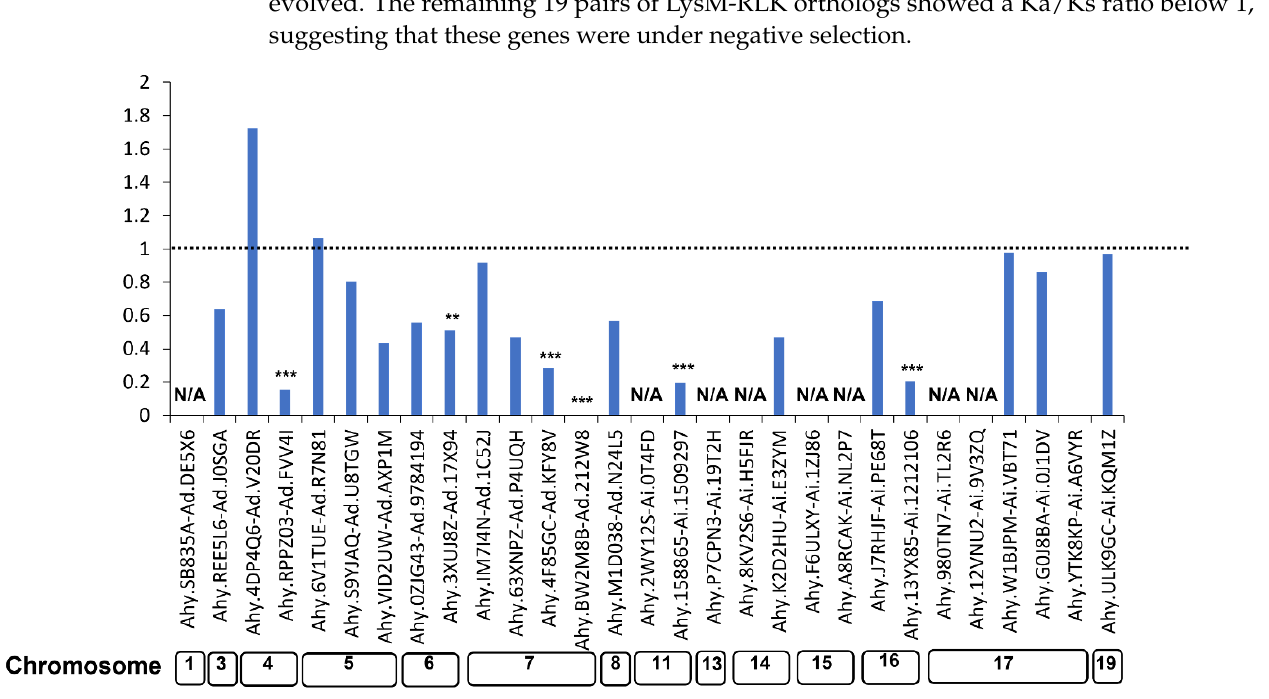
Figure 3. Ka/Ks ratios of the LysM-RLKs between cultivated peanut and its diploid wild ancestors. The chromosomal location of the LysM-RLKs from cultivated peanuts is shown in the boxes. All statically significant Ka/Ks ratios are below 1 (the dotted line), indicating the gene pairs are under negative selection. N/A means that no Ka/Ks ratio was calculated, due to the 100% amino acids sequence identity between the genes in the pair. Star (*) indicates the significant level from Fisher’s exact test, as follows, **: p < 0.01, ***: p < 0.001. Figure was drawn using R.